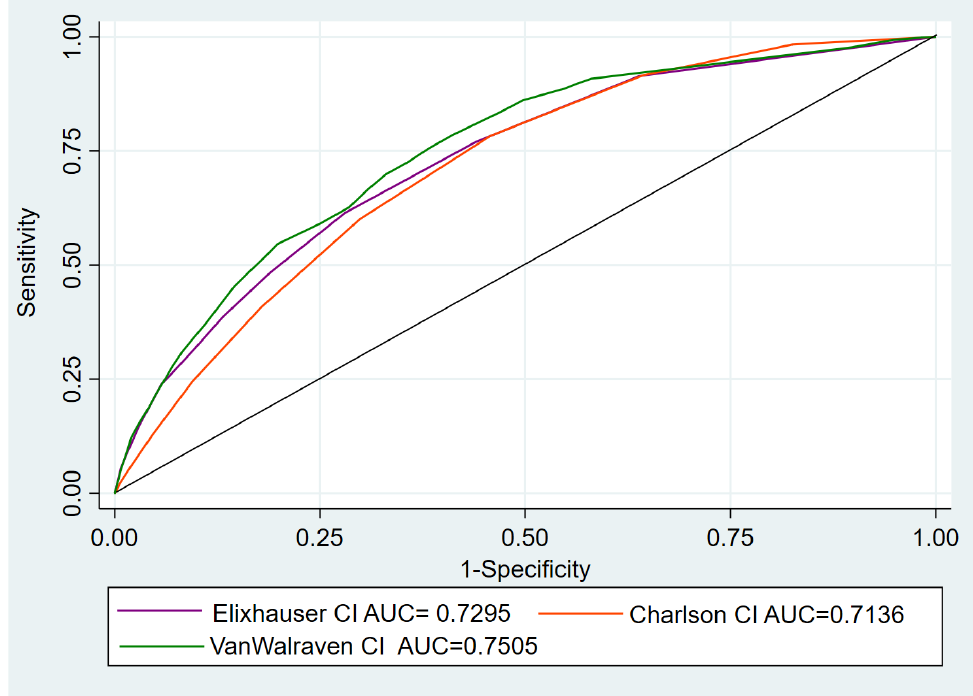
Figure 1. ROC curve for predicting in-hospital mortality by Elixhauser, Walraven and Charlson comorbidity